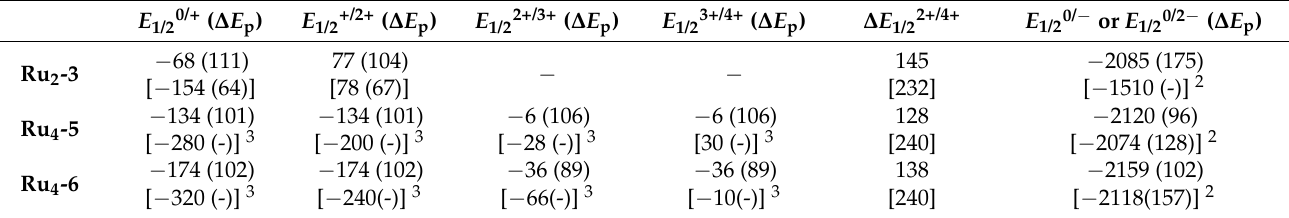
experimental voltammograms